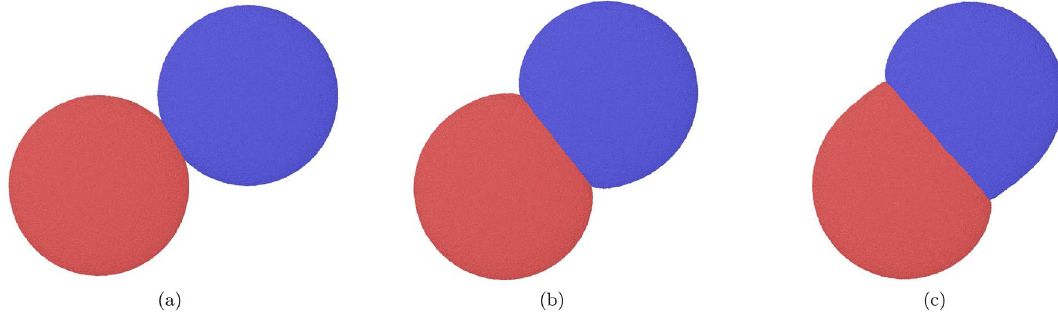
0.5 around the moment of closest =